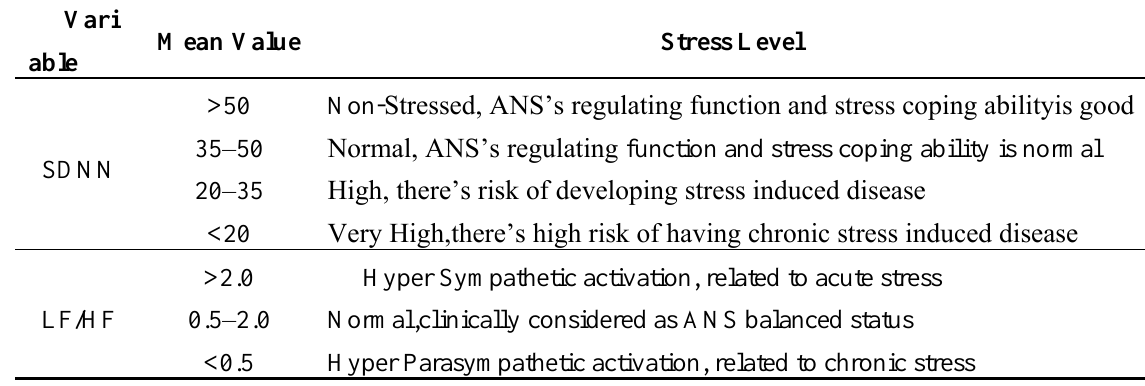
Table 3. Corresponding relation between the mean values of HRV measures and stress level [31].